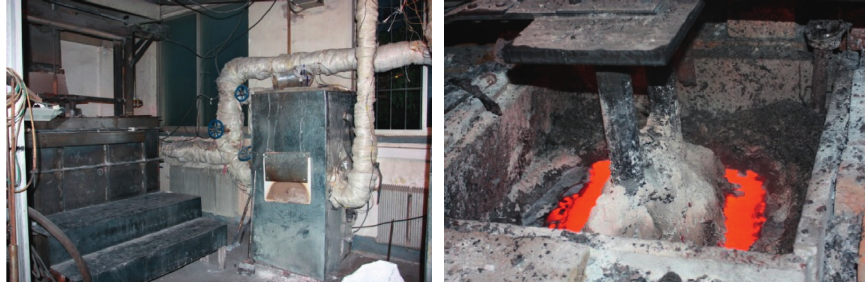
Figure 5: Photos of the 2 kA lab-scale heat-exchanging aluminum reduction